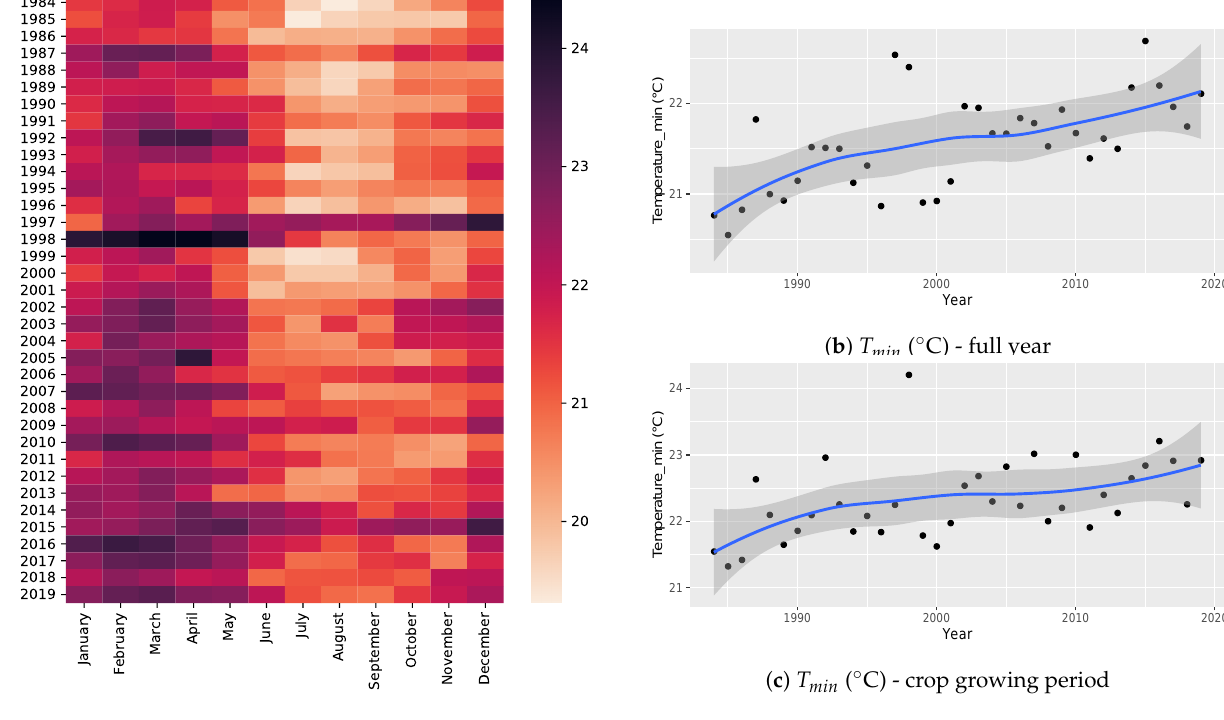
Figure 5. Time series of average minimum temperature ( ◦ C) in Manabi from 1984 to 2019. ( a ) Heat-map of T min ( ◦ C) per each month and year. The color scale represents the temperature in ◦ C. ( b ) T min ( ◦ C) averaged during the full year. ( c ) T min ( ◦ C) averaged during the maize crop growing period in Ecuador (January–May). Each dot represents one record, the blue line shows the smoothed time series and the shaded area represents the 95% confidence